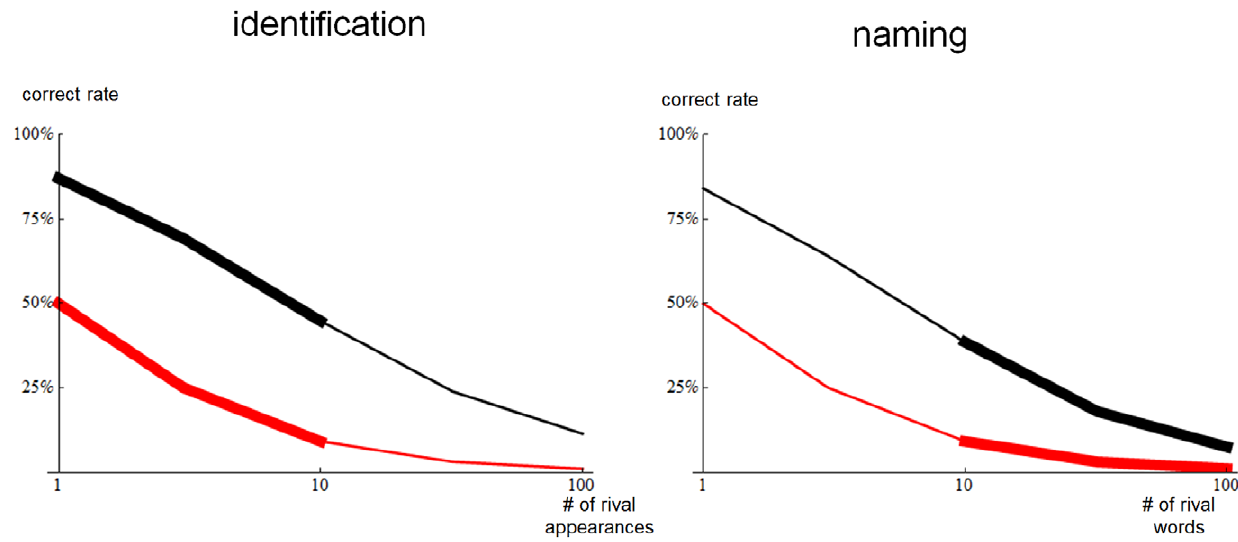
Figure 9. Performance as a function of the number of rival responses. In both plots, the black curve shows performance of the computational system using distributional similarities ( DST ), colour & textons for appearance, the MIRRORING algorithm and 512 already-known appearances. The red curve shows baseline chance performance. The horizontal axes show the number of incorrect rival answers that are presented alongside the correct answer. The left hand end of each horizontal axis corresponds to just one rival, which is the condition used in all other experiments (figures 6 & 7). The thicker parts of the curves indicate the range of numbers of rival that are relevant to human learning.